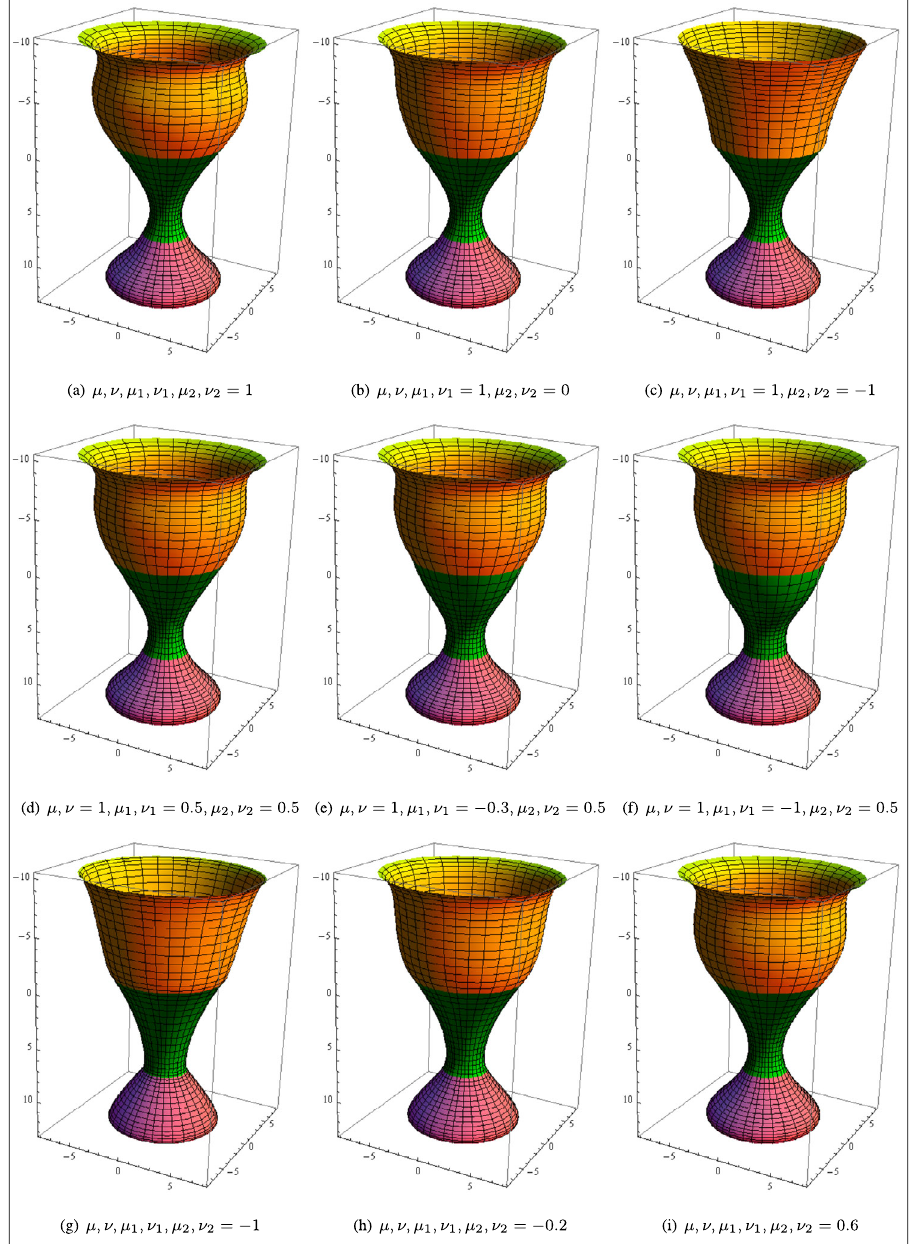
Figure 22 Combine GBT-Bézier rotation surfaces with different shape